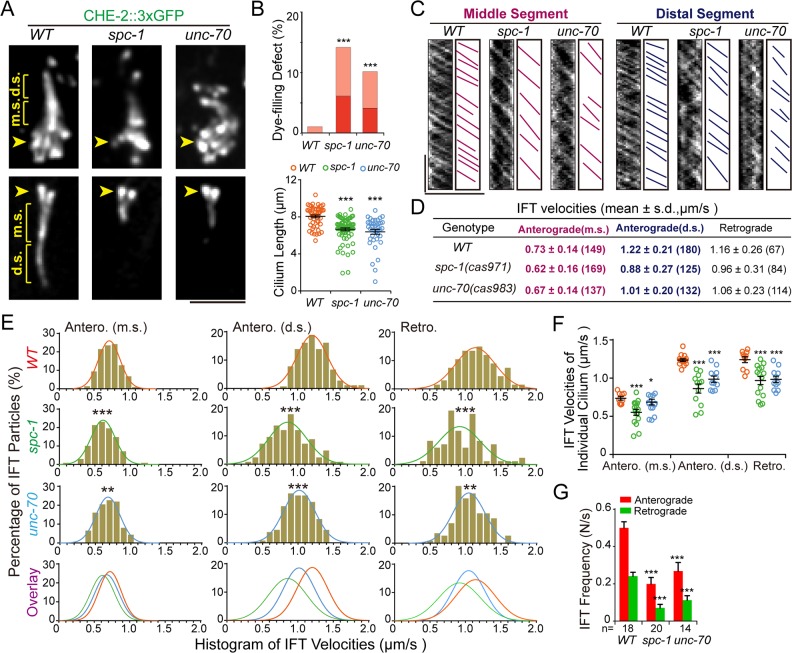
Spectrin supports ciliogenesis.(A) Amphid (top) and phasmid (bottom) cilia in WT, spc-1 (cas971), and unc-70 (cas983) mutants were labeled with IFT80/CHE-2::3×GFP. Arrowheads, the ciliary base and TZ; m.s. or d.s. of sensory cilia. Scale bar, 5 μm. (B, top) Quantifications of the animals showing no staining (red) or weak staining (light red) defects in the dye-filling assay in phasmid cilia from WT and mutant animals (N = 250–350). (Bottom) Cilium length (mean ± SEM). The color code for each genotype is indicated. ***p < 0.001. (C) Kymographs show particle movement along the ciliary m.s. or d.s. of phasmid cilia in WT and mutants. Representative particle traces are marked with magenta and indigo lines. The scale bars represent 5 μm (horizontal) and 5 s (vertical). (D) Summary of the anterograde and retrograde velocities of CHE-2::3×GFP in WT and spectrin-mutant cilia that have the d.s. and m.s. Numbers of IFT particles are shown in the brackets. (E) Histogram of CHE-2::3×GFP velocities. (Left) Anterograde IFT along the middle segments. (Middle) Anterograde IFT along the d.s. (Right) retrograde IFT. Each plot was fit by a Gaussian distribution. Comparisons were between the WT and mutants, **p < 0.01; ***p < 0.001. (F) The anterograde and retrograde IFT movement velocities (mean ± SEM) of CHE-2::3×GFP in individual WT and spectrin-mutant animals. Color codes for genotype are the same as in (B) and (E). Comparisons were between the WT and mutants, *p < 0.05; ***p < 0.001. (G) Anterograde (red) and retrograde (green) IFT frequencies (mean ± SEM) in WT and spectrin-mutant cilia. Numbers of kymographs used for quantification are shown above the genotypes. Comparisons were between the WT and mutants. ***p < 0.001. Data associated with this figure can be found in S1 Data. d.s., distal segment; GFP, green fluorescence protein; IFT, intraflagellar transport; m.s., middle segment; TZ, transition zone; WT, wild type.